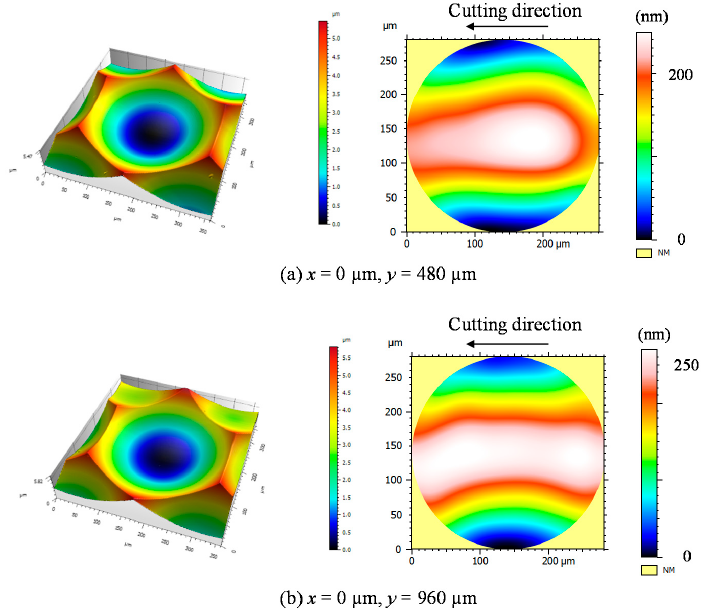
Figure 19. Three-dimensional topographies of lenslets at different locations and their form error distributions.